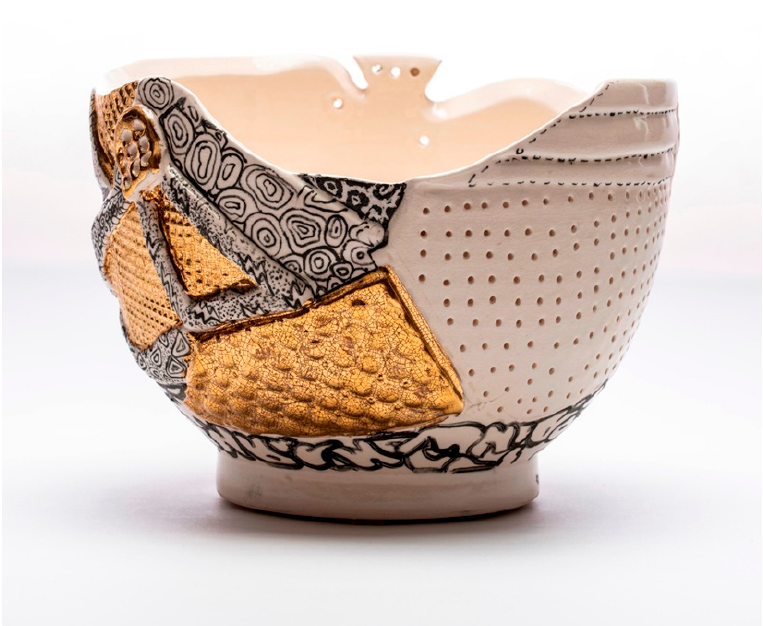
Figure 9. Stunting: Clean Joint, 2018 , Porcelain, china paint, luster, 8 × 10.5 × 10.5 in. Image by KeneK Photography, courtesy of Wexler Gallery.